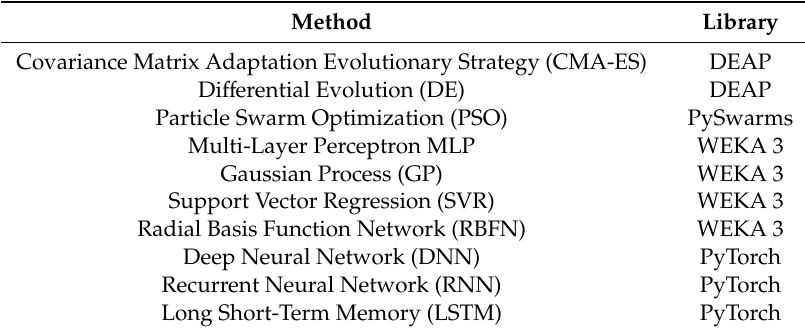
Table 2. Methods and library